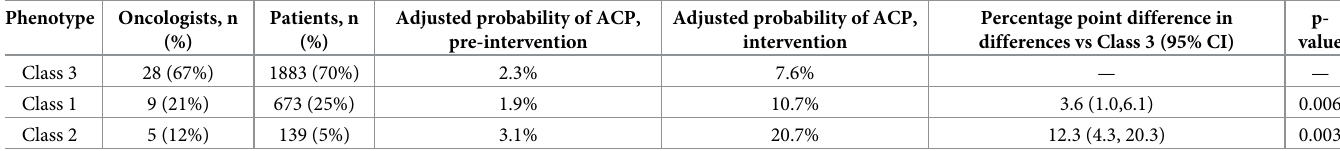
Table 2. Association between oncologist phenotype and response to the intervention. Phenotype Oncologists, n (%)